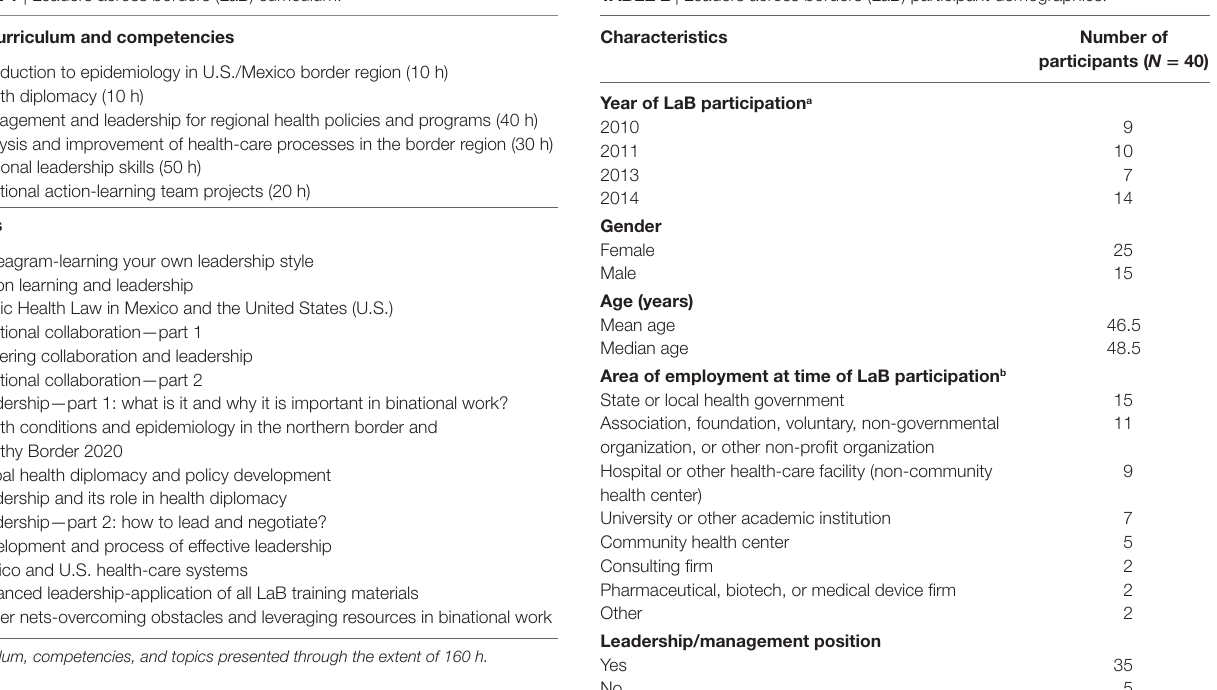
taBlE 1 | Leaders across borders (LaB) curriculum. taBlE 2 | Leaders across borders (LaB) participant